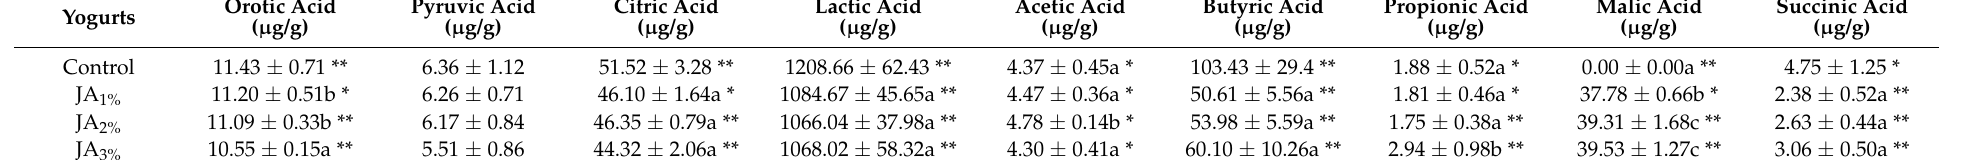
Citric Acid ( µ g/g)